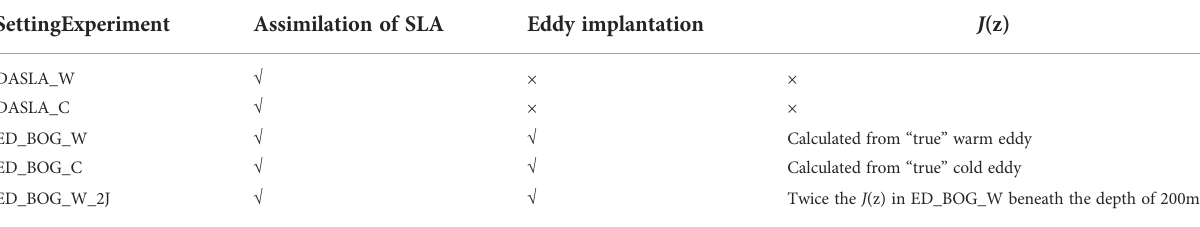
TABLE 2 The design of idealized prediction